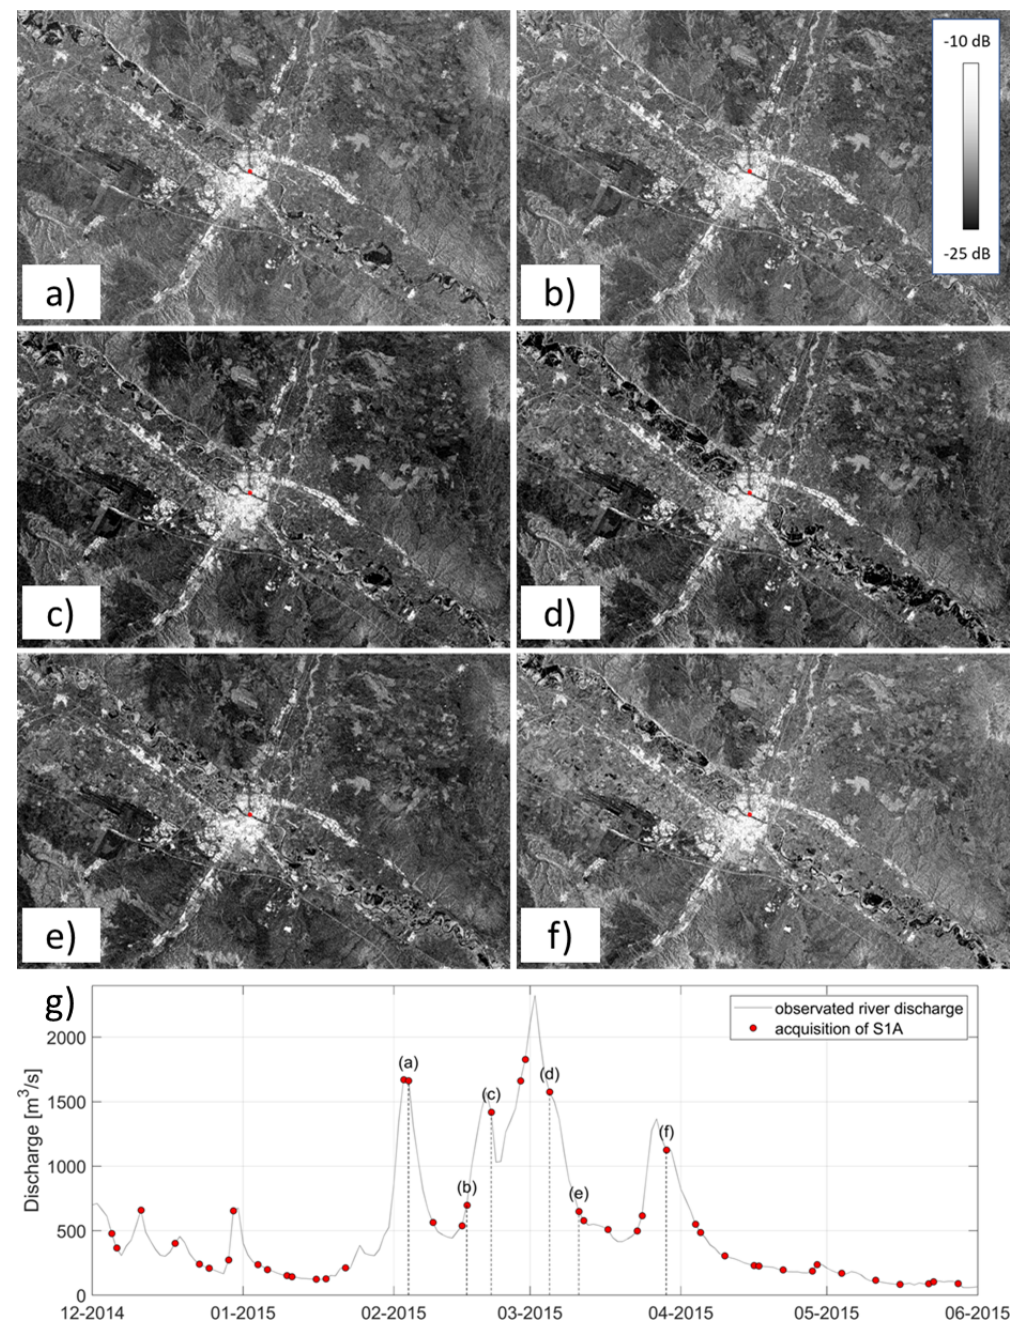
Figure 9. Flood event occurring in the period February–March 2015 at Zaragoza (g) . The letters in the hydrograph (a–f) correspond to the SAR images on the top (© Google Earth